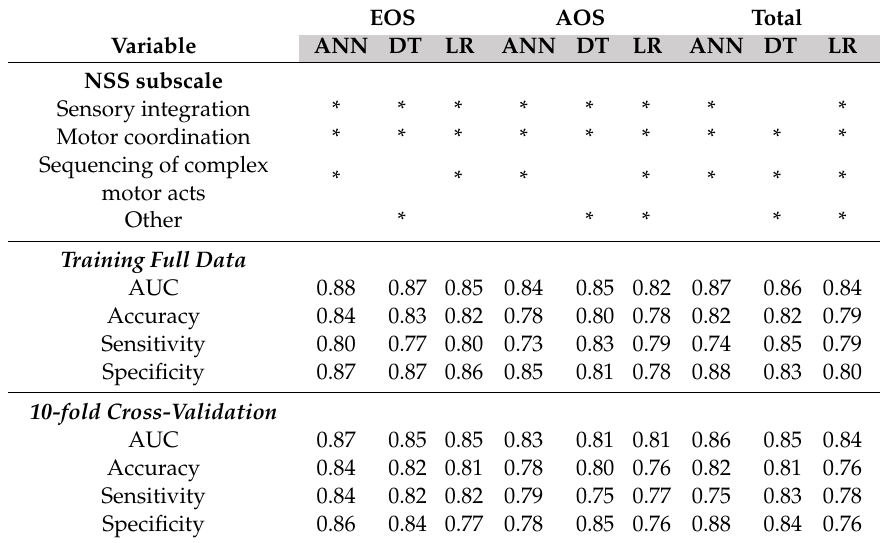
Table 3. Performance comparison of NSS-based data mining models for training full data and 10-fold cross-validation results.